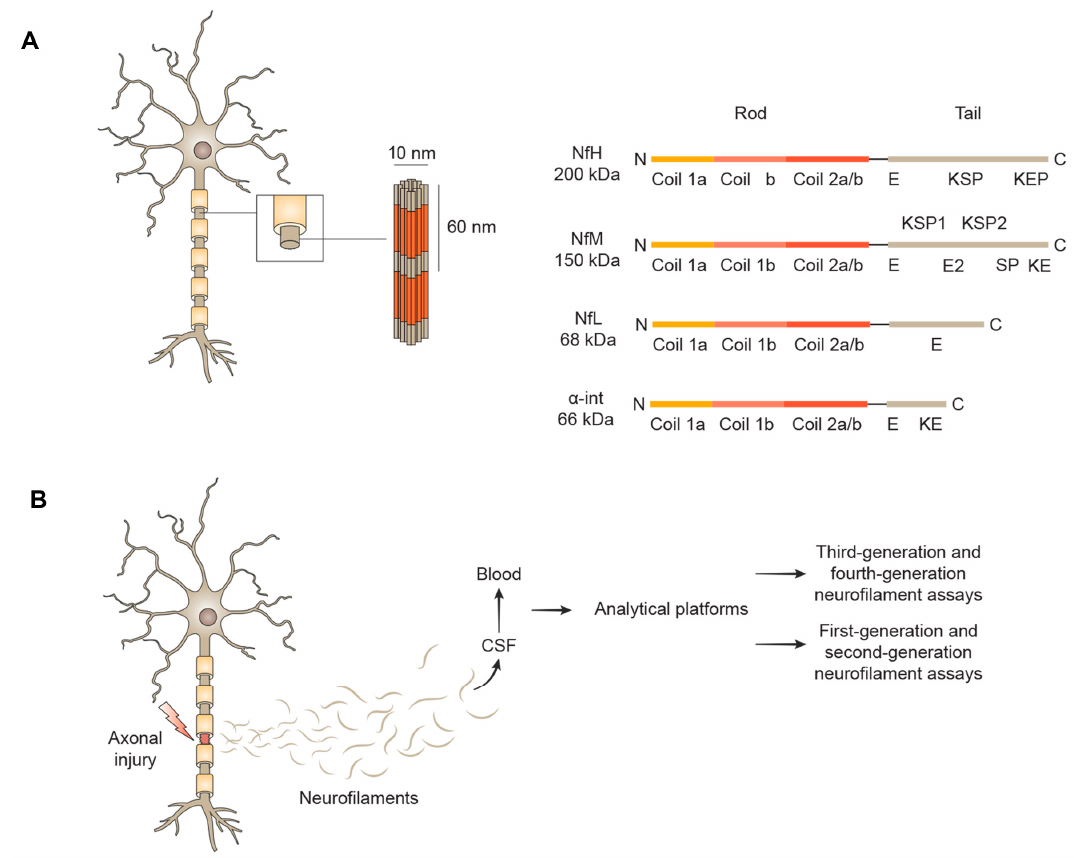
Figure 1. A . Overview of neurofilaments structure. Neurofilaments (Nfs) are cylindrical structure of 10 nm diameter abundantly expressed by large calibre myelinated axons. According to the molecular mass of their subunits, Nfs are classified in neurofilament light chain (NfL), neurofilament medium chain (NfM), neurofilament heavy chain (NfH) and α -internexin ( α -int). Nfs subunits are formed by a conserved α -helical rod domain, a variable amino-terminal globular head region and a carboxy-terminal tail domain. Each carboxy-terminal tail is variably enriched of glutamic-acid (E), lysine-serine-proline (KSP), lysine-glutamic acid-proline (KEP), serine-proline (SP) and lysine-glutamic acid (KE) segments. B . Detection methods of Neurofilaments in biological fluids after axonal damage. Axonal injury induces Nfs release in extracellular fluids, and subsequently, given its proximity to central nervous system (CNS), into cerebrospinal fluid (CSF). First- and second- generation assays (immunoblot and enzyme-linked immunosorbent assay (ELISA), respectively) are able to measure Nfs levels in CSF, but present limited sensitivity for Nfs detection in blood. Third-generation (electrochemiluminescence) and fourth-generation assays (single-molecule array) can also detect ultralow concentrations of Nfs in blood, enabling longitudinal studies in patients and healthy controls